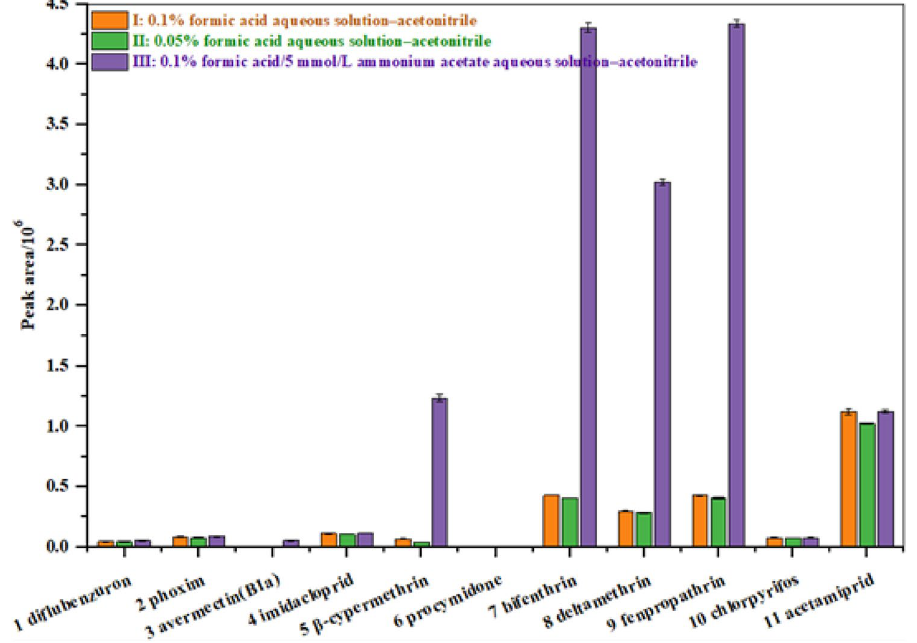
Figure 1. When using HSS C 18 , the peak areas of 11 pesticides in three different mobile